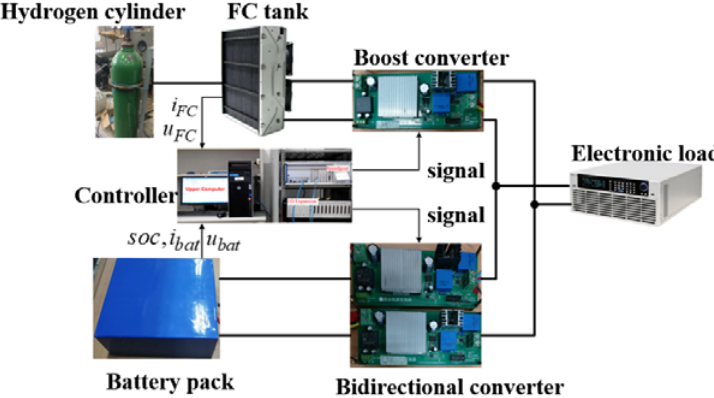
Figure 15. The schematic diagram of the designed HPS for a UAV. Table 2. The main parameters of HPS.